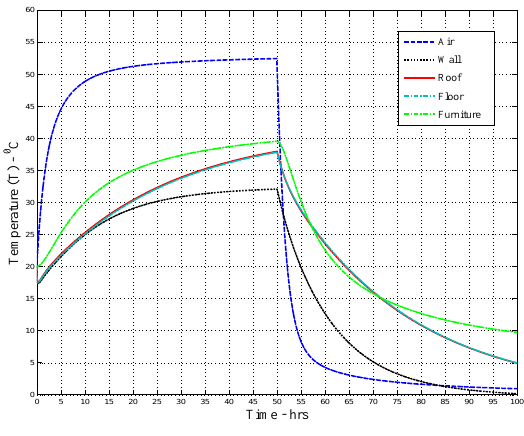
Figure 4: Temperature variations of air and other ele- ments internal to the building